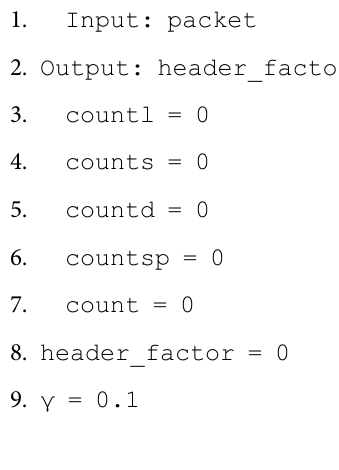
Algorithm 1. Function update trust according to headers